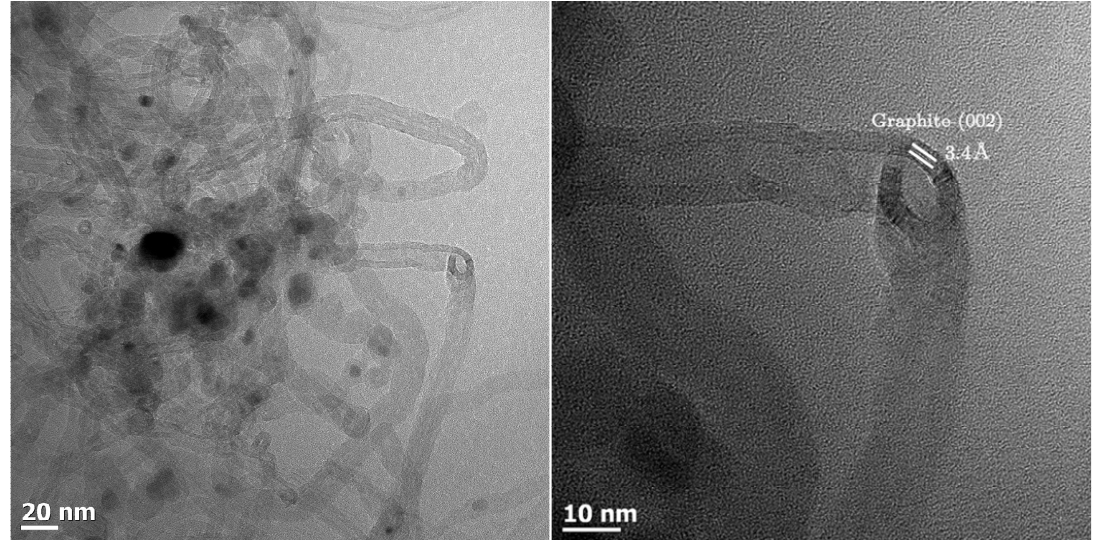
Figure 4. TEM image of the sample containing 0.5 wt.% aluminum (Al0.5) after CO-TPR showing metal particles encapsulated in multi-wall carbon nanotubes.